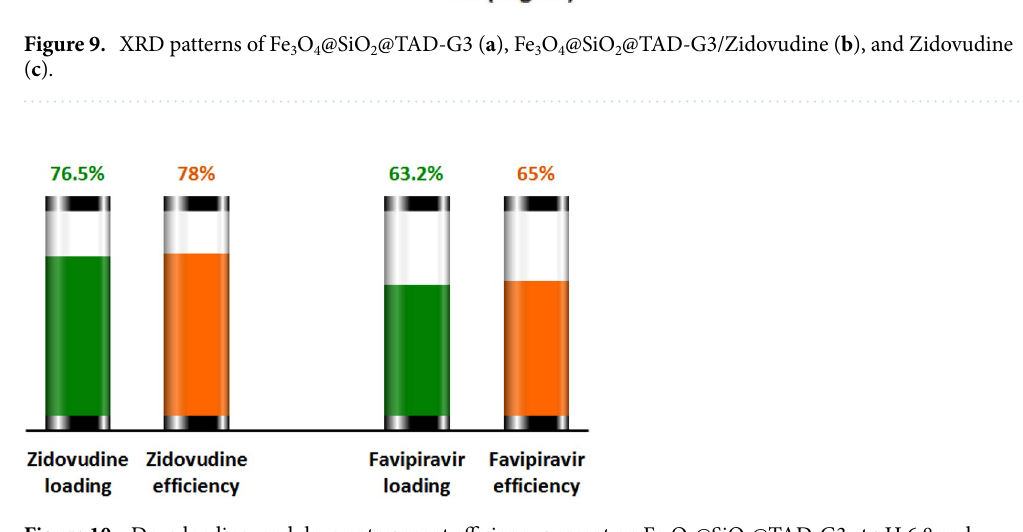
Figure 10. Drug loading, and drug entrapment efficiency percent on Fe 3 O 4 @SiO 2 @TAD-G3 at pH 6.8 and 25